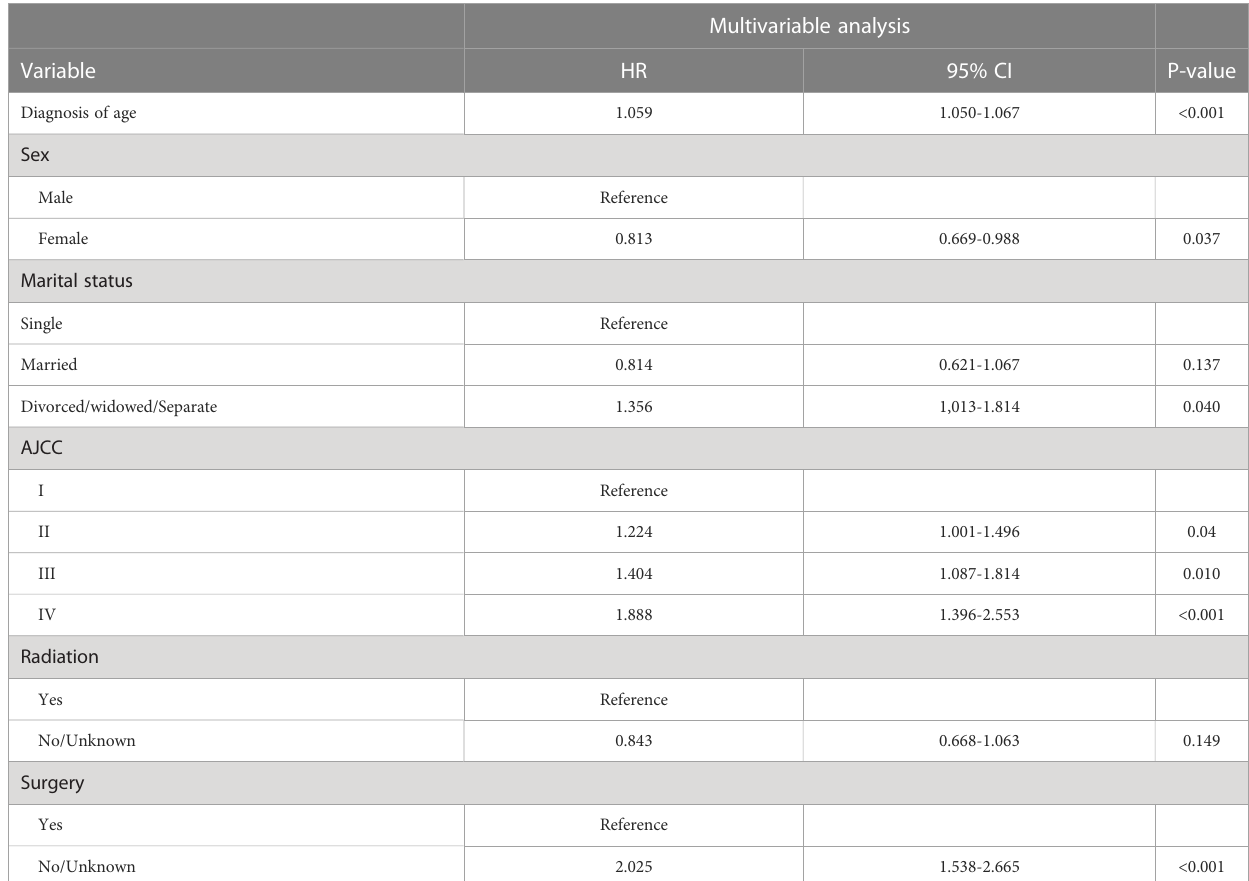
TABLE 2 Selected variables by multivariable Cox regression analysis.